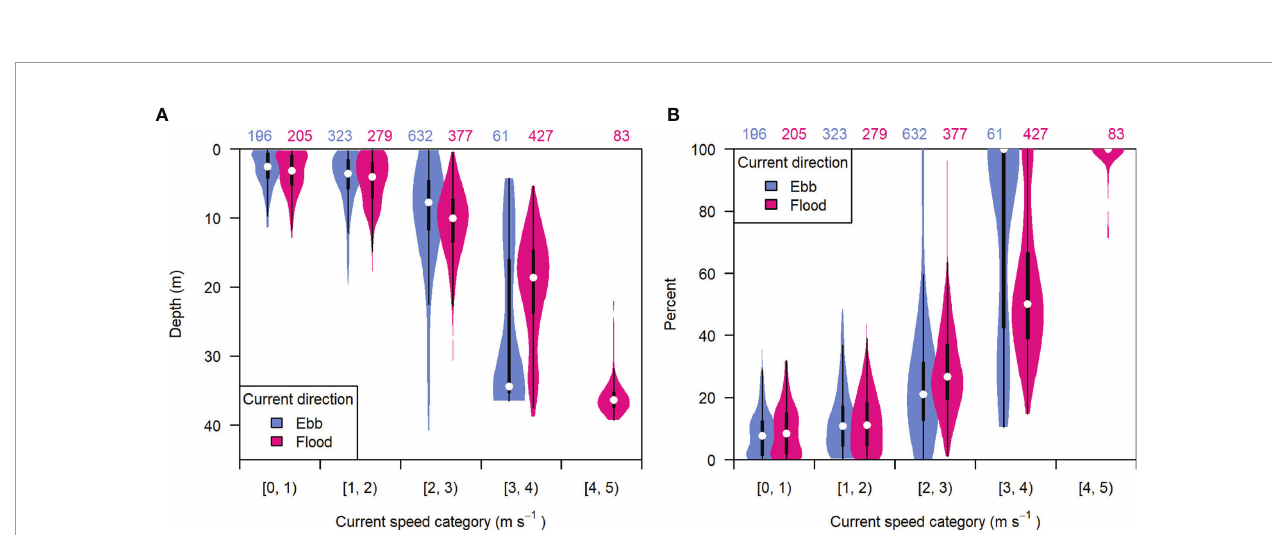
FIGURE 7 | Distribution of depths and current speeds sampled during (A) the entire dataset, (B) recording periods within 2 days of spring tides, and (C) recording periods within 2 days of neap tides. Upper panels: the current speeds recorded during all periods of the respective data subset, representing speeds that would be sampled throughout the water column if there were no contamination from entrained air. Lower panels: the depth and current speed distribution of uncontaminated recording periods. Each depth bin spans 5% of the water column (the lowermost two depth bins were not sampled in any recording periods due to the height of the near fi eld exclusion above the sea fl oor). To the right of each bar is the percentage of total recording periods within the respective data subset (e.g., entire dataset, spring tide, or neap tide).